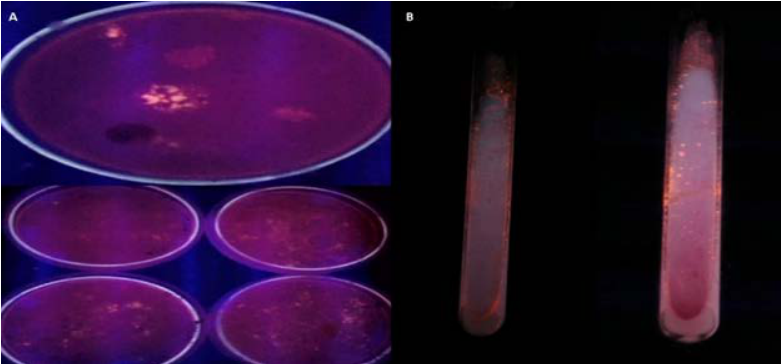
Fig.2. Screening of lipase bacteria using the Rhodamine-B agar medium.